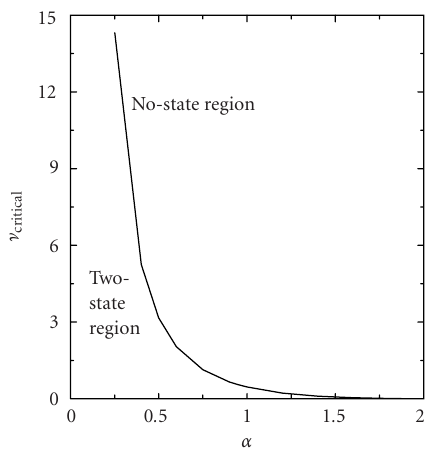
Figure 3.4. The variation of ν critical as a function of the parameter α for unstaggered stationary local- ized states λ = 1. ν critical is obtained from (3.10) and (3.11) in the text. Note that the curve separates the two-state region from the no-state